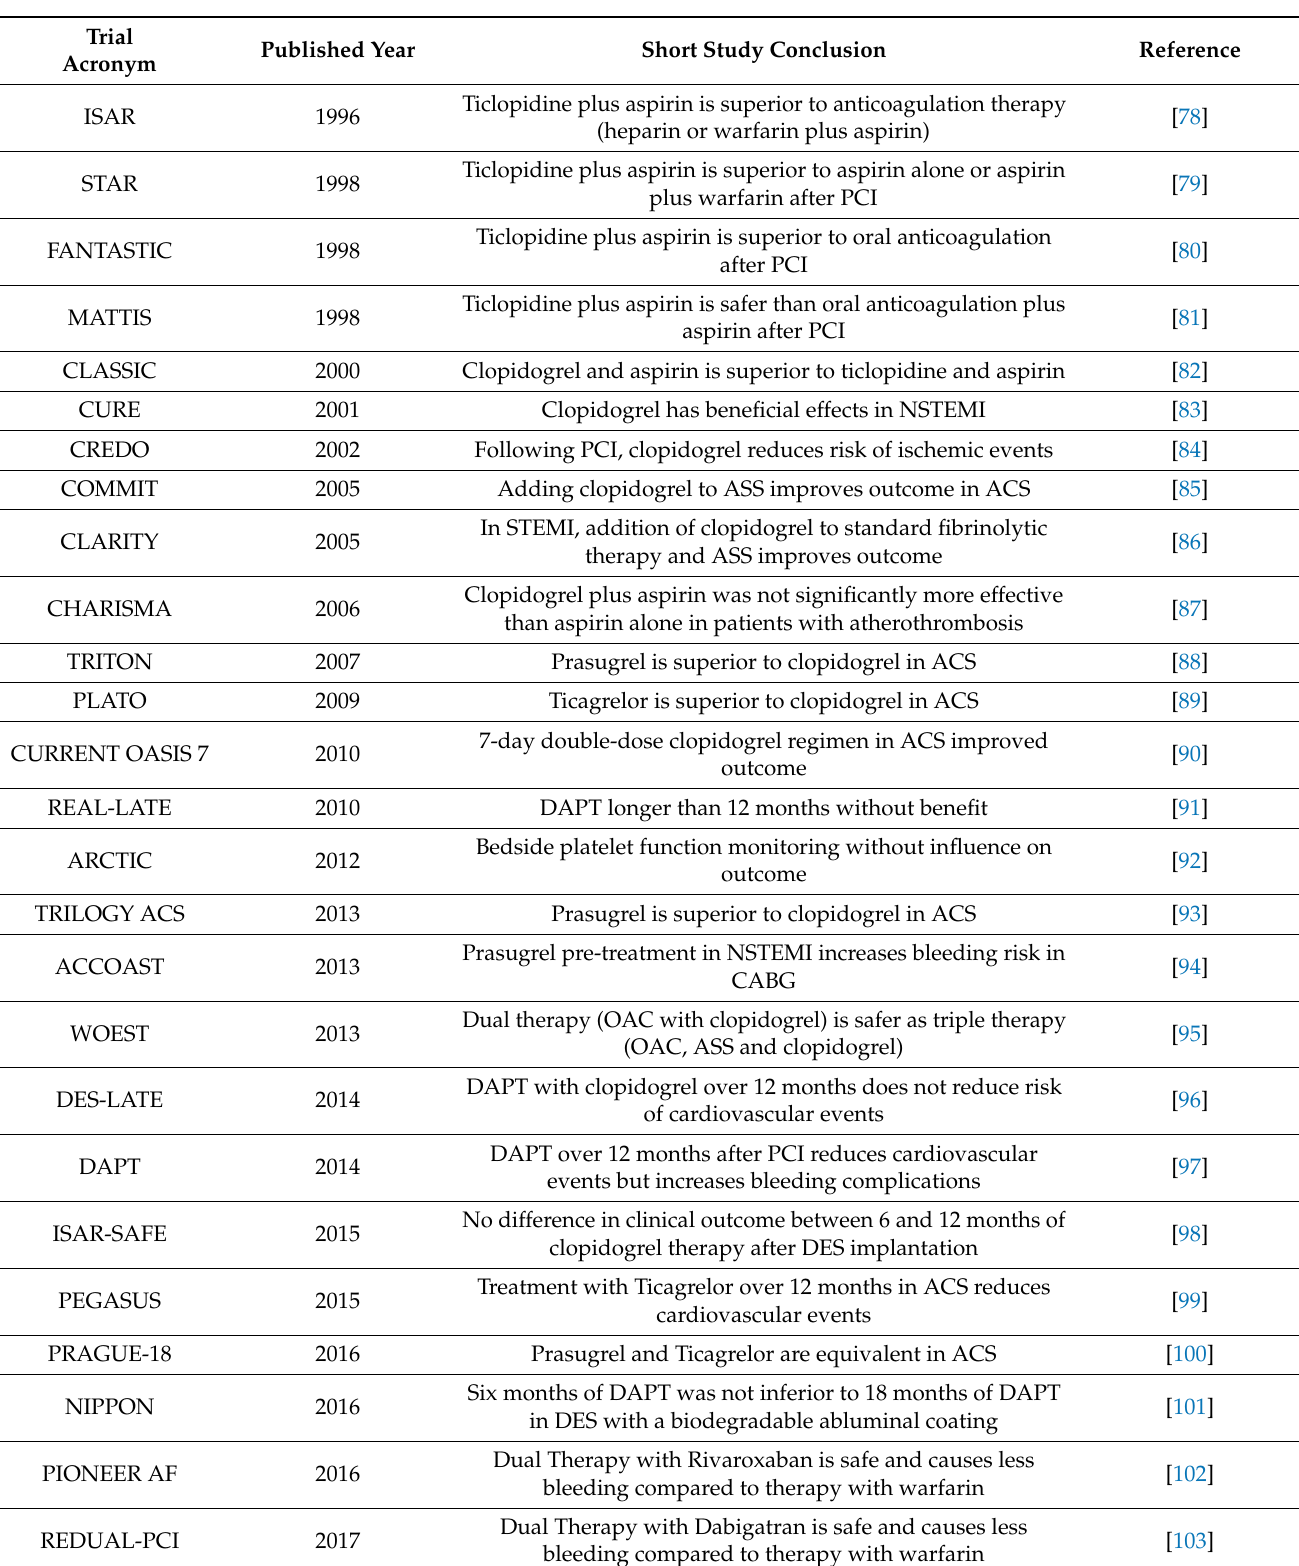
Table 1. The most important studies on antithrombotic drugs in the last 30